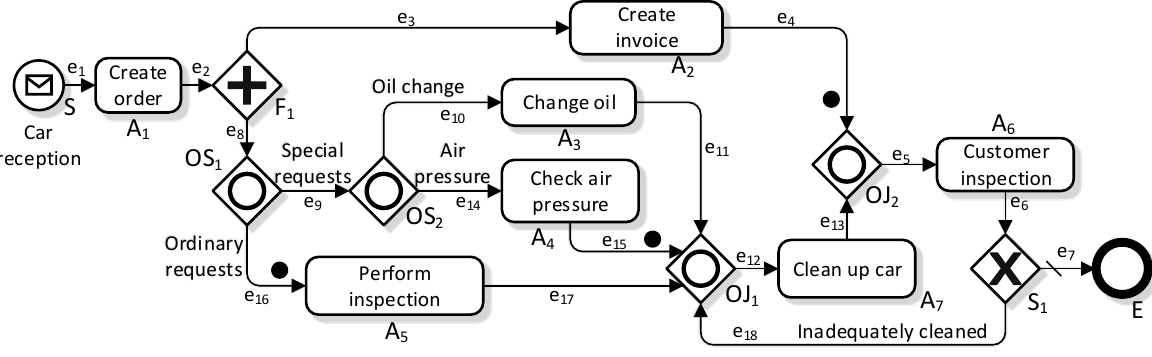
Figure 9. Car service process with labels